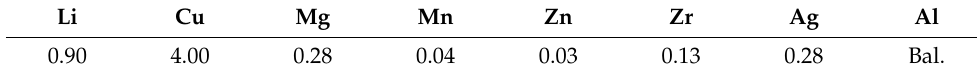
Table 1. Chemical compositions (wt%) of the AA2195